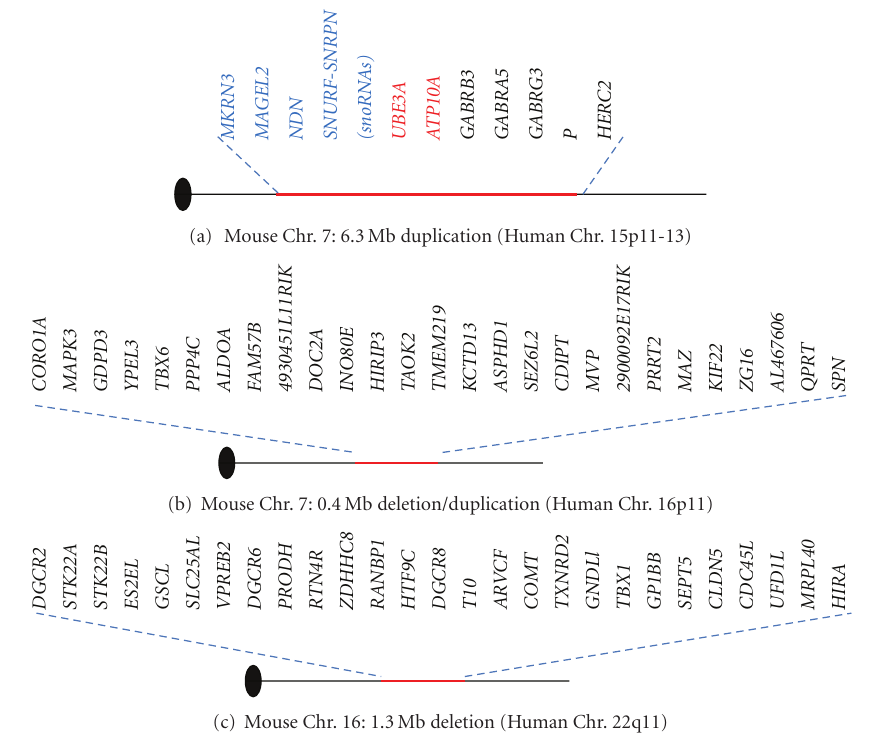
(c) Mouse Chr. 16: 1.3Mb deletion (Human Chr. 22q11) Figure 2: Schematic representation in studies applying chromosome engineering. Published in (a) Nakatani et al. [10], (b) Horev et al. [12], (c) Stark et al. [14]. The paternally, maternally expressed, and nonimprinting genes were labeled with blue, red, and black, respectively.